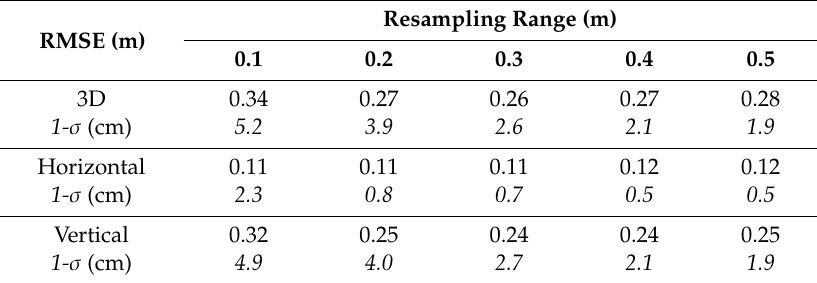
Figure 19. RMSE results of the unmanned aerial vehicle (UAV)-based inventory management scenario and corresponding error bars at a signal-to-noise ratio (SNR) of 50 dB and measurement update rate of 20 Hz. Table 6. RMSE results of the UAV-based inventory management scenario.